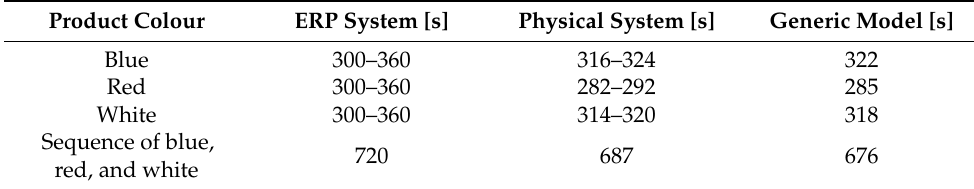
Table 3. Comparison of Fischer Production Lead Time among ERP System, Physical System, and Simulated Model.